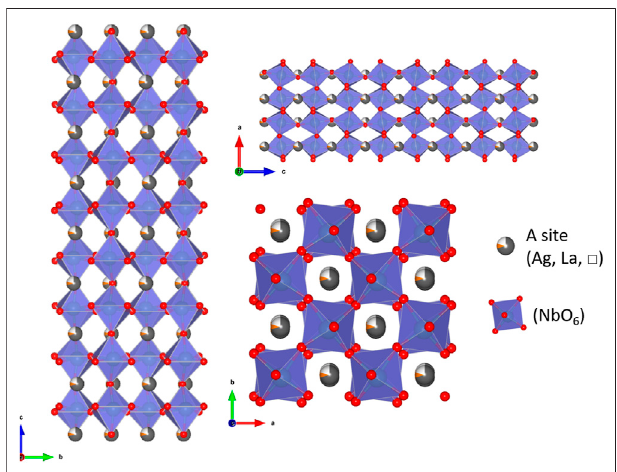
FIGURE 1 | (A-B-C) respectively a, b, and c axis view of Ag 0.70 La 0.10 □ 0.20 NbO 3